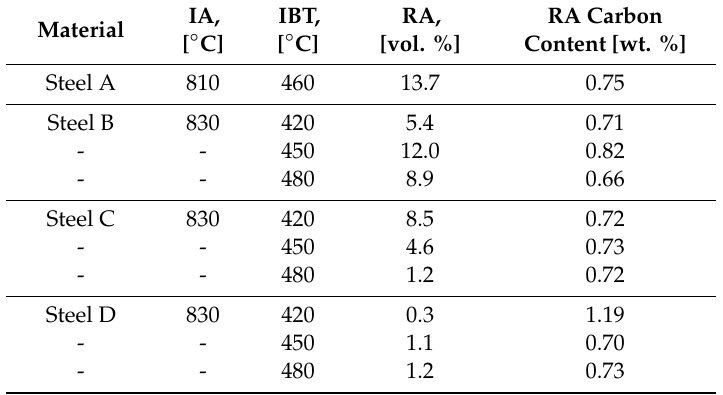
Table 7. Retained austenite content (in volume percentage) and carbon content (in weight